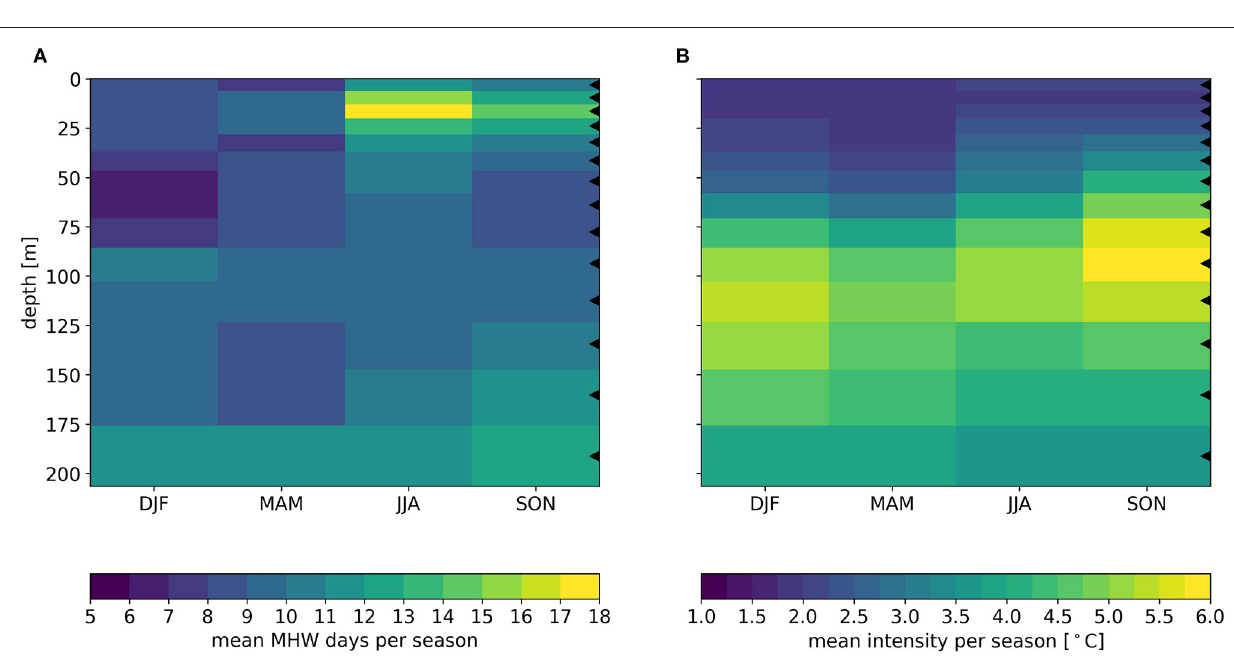
FIGURE 9 | Seasonal distribution of total MHW days (A) and mean intensity per season (B) with depth (averaged over ecoboxes, see Figure 1 ); markers on the right indicate depth levels of the model. Acronyms for seasons are: December, January, and February (DJF), March, April, and May (MAM), June, July, and August (JJA), and September, October, and November